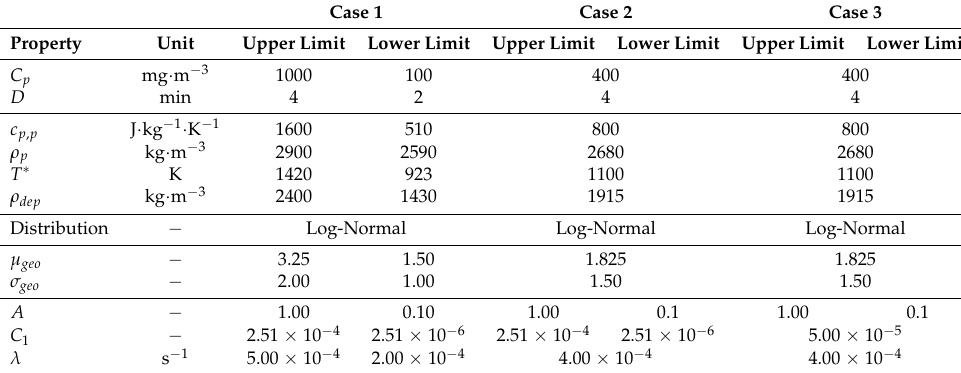
Table 4. Input data for the three hypothetical cases examined, showing the increase in certainty for each variable between input datasets.